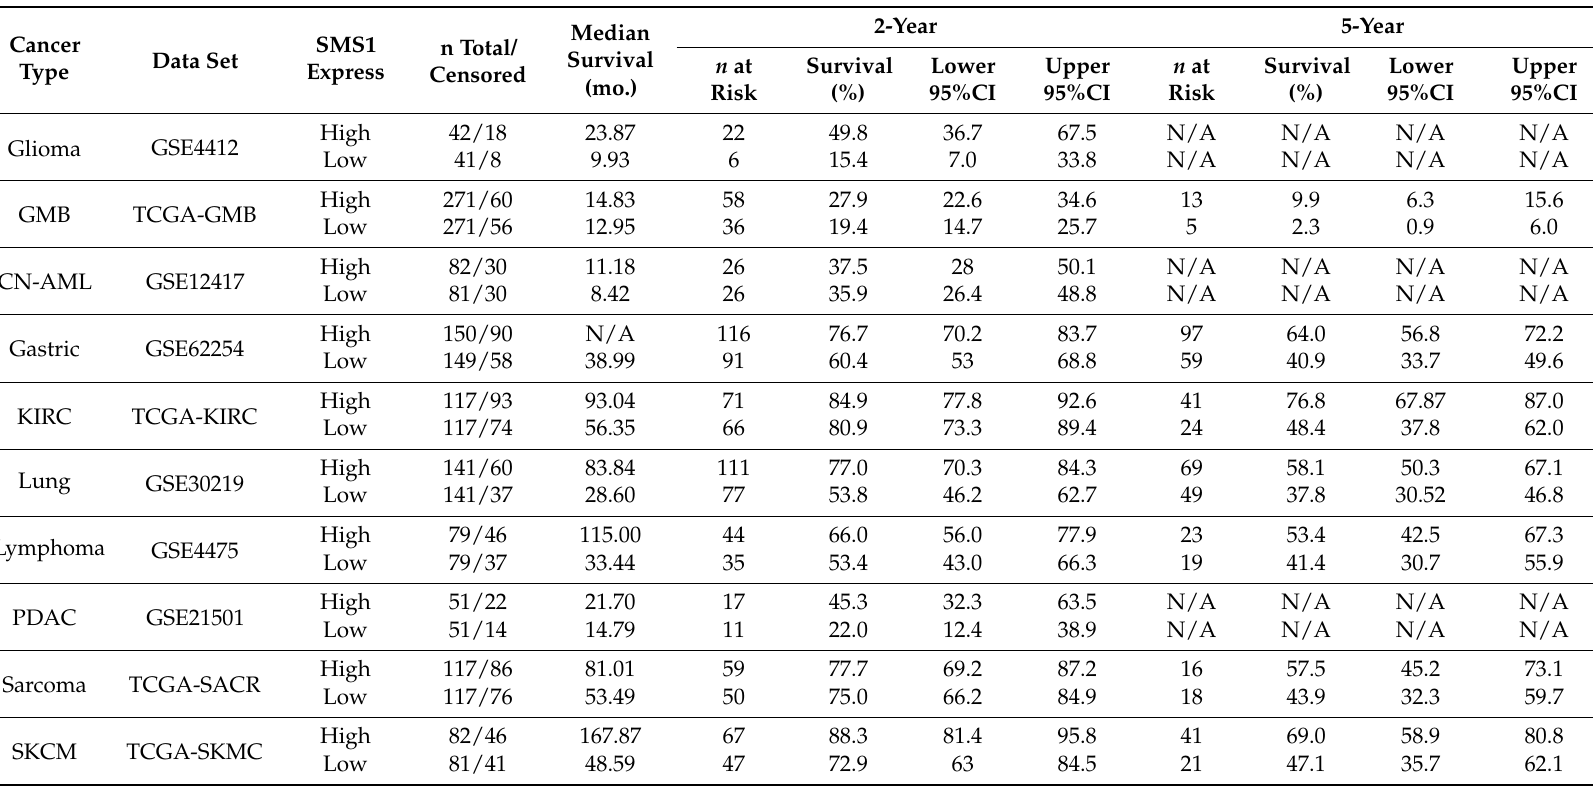
Table 1. Patients at risk from Kaplan-Meier plots in Figure 2. Patients were censored when they were alive at the time of study; mo.: months; n: number of patients; CI: confidence